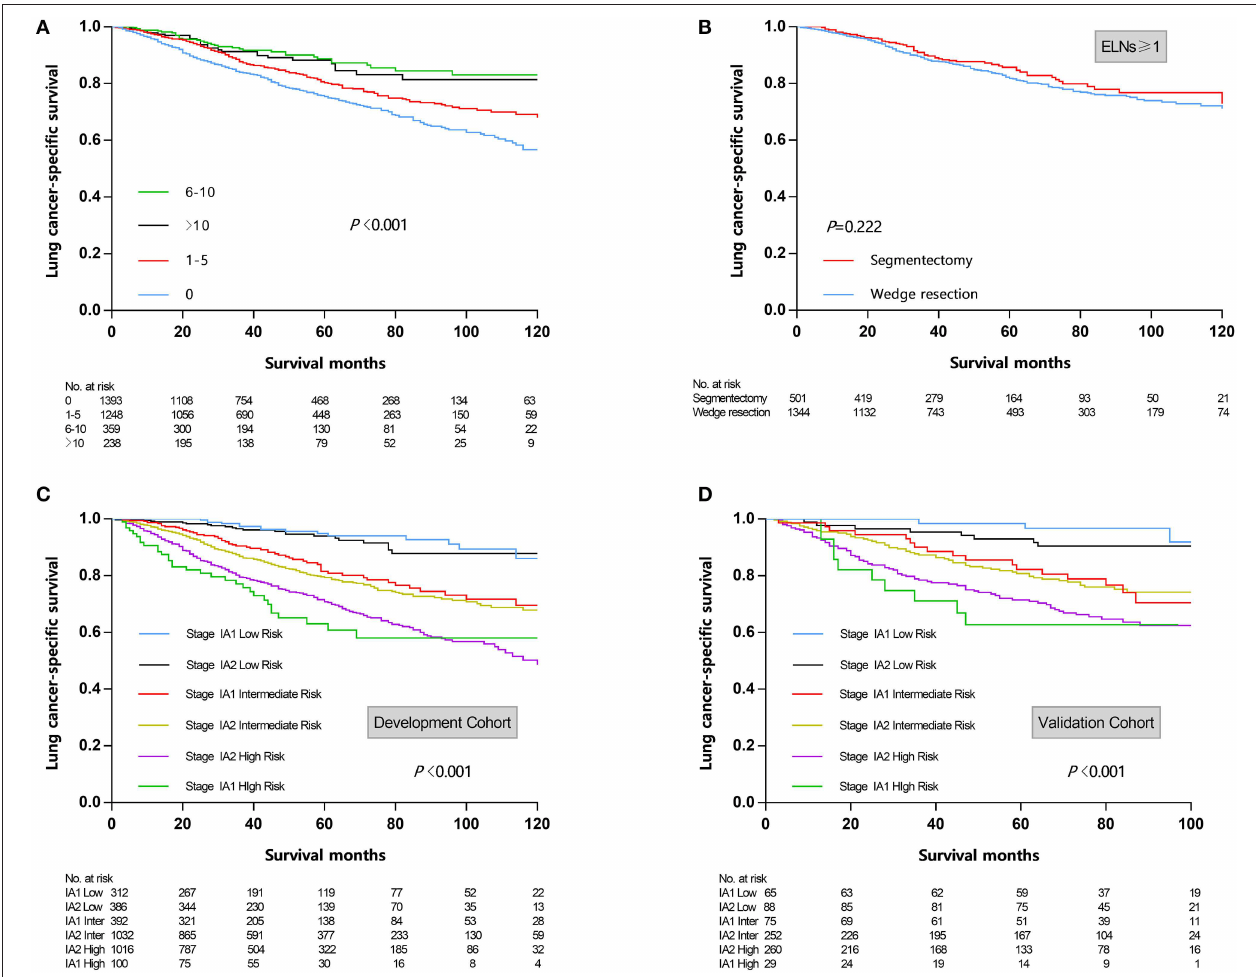
FIGURE 1 | (A) Survival curves stratified by examined lymph nodes count. (B) Survival curves stratified by surgical procedure (wedge resection vs. segmentectomy) in patients undergoing lymph nodes examination. (C) Risk group stratification within respective TNM stage in development cohort. (D) Risk group stratification within respective TNM stage in validation cohort. ELNs, examined lymph